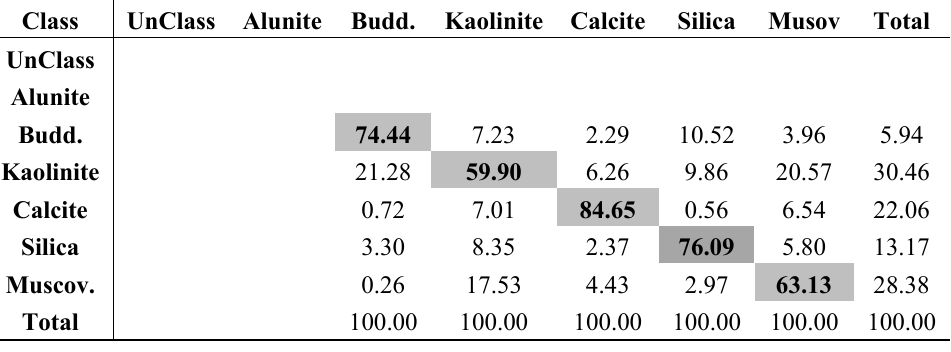
Table 5. Confusion matrices comparing simulated WV-3 mineral mapping to AVIRIS mineral mapping for combinations of similar minerals. ( a ) Kaolinite and Alunite combined (no unclassified): Overall accuracy is 67.80%; Kappa Coefficient is 0.5642 (Good); ( b ) Kaolinite and Muscovite combined (no unclassified): Overall accuracy is 70.24%; Kappa Coefficient is 0.5729 (Good); ( c ) Kaolinite, Alunite, and Muscovite combined